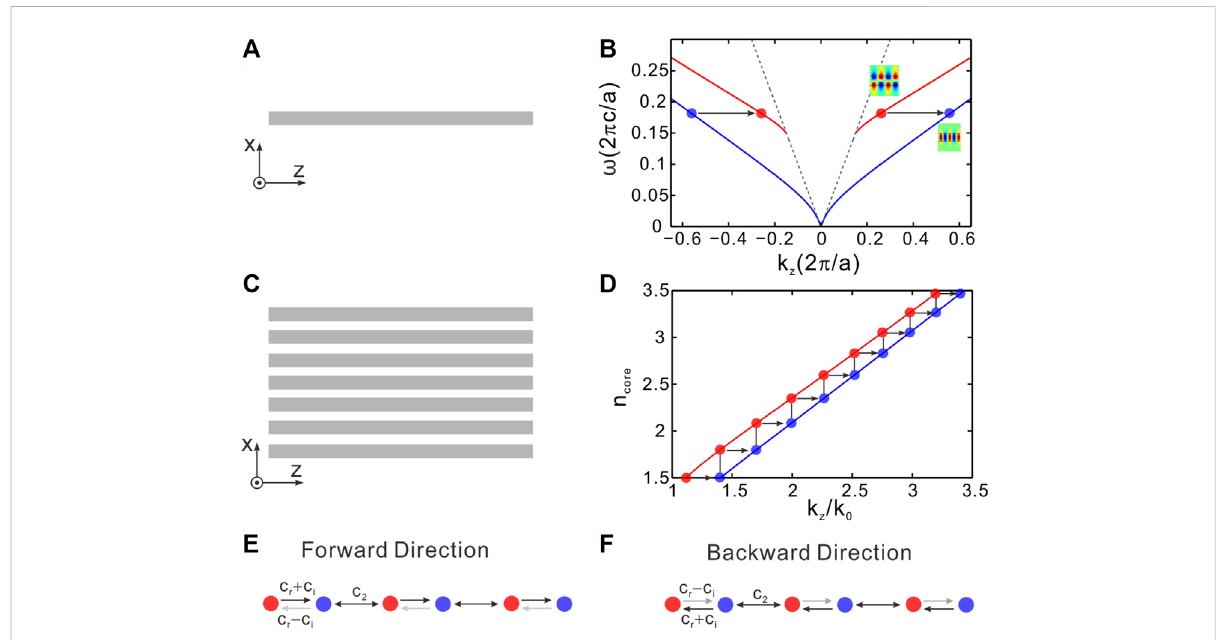
FIGURE 1 Schematic to construct non-Hermitian SSH lattice using complex modulation. (A) The diagram of a slab waveguide. (B) Band structures of the waveguide. The blue and red lines stand for symmetric and anti-symmetric modes. Their mode pro fi les ( E y ) are shown in the insert. The two modes are coupled under spatial modulation. (C) The diagram of a waveguide array. (D) Propagation constants versus the refractive index of waveguide core. The width and incident wavelength are fi xed at w = 1 μ m and λ = 1.55 μ m. (E) and (F) are the effective lattice for forward and backward directions, respectively. The intracell couplings are different for two